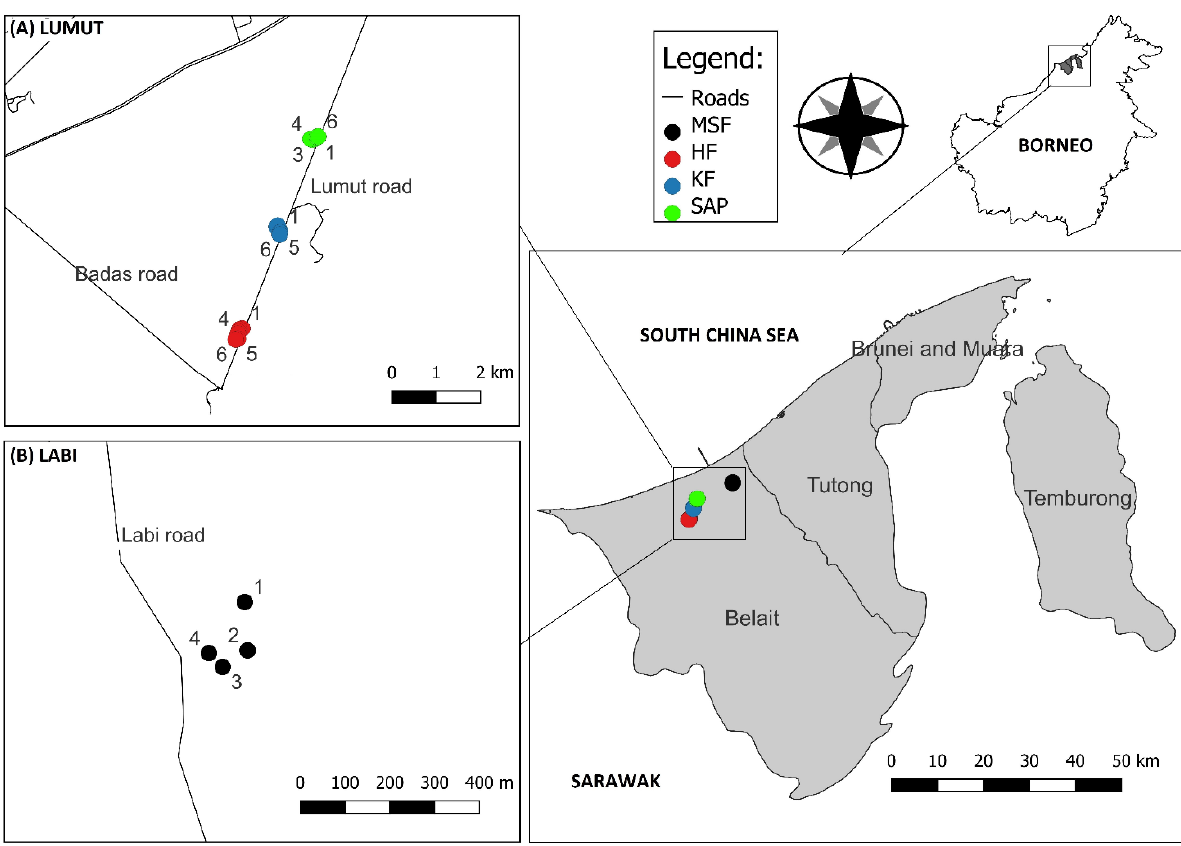
Figure 1. Locations of the study sites consisting of: (a) six 3 m × 3 m plots in heath forest (HF 1-6), kerapah forest (KF 1-6) and Shorea albida peat-swamp forest (SAP 1-6) in Lumut, and (b) four 3 m × 3 m plots in mixed peat-swamp forest (MSF 1-4) in Labi in the Belait District, Brunei Darussalam, Northwest Borneo. Distances between plots within the same forest type were approximately 50 m. The MSF site in Labi is located approximately 13.4 km away from the HF, KF and SAP sites in